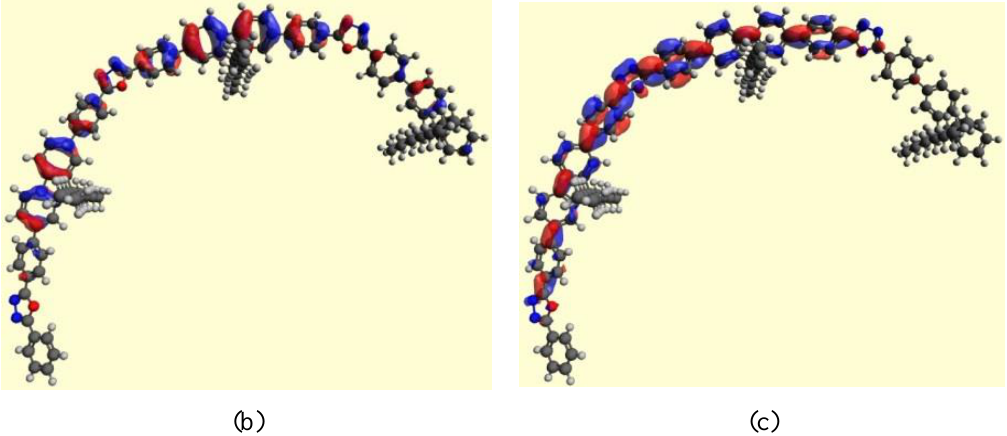
Figure 7. Optimized geometry and spatial distribution of chain segment consisting of three structural units ( a ), and spatial distribution of HOMO ( b ) and LUMO ( c ) orbitals.